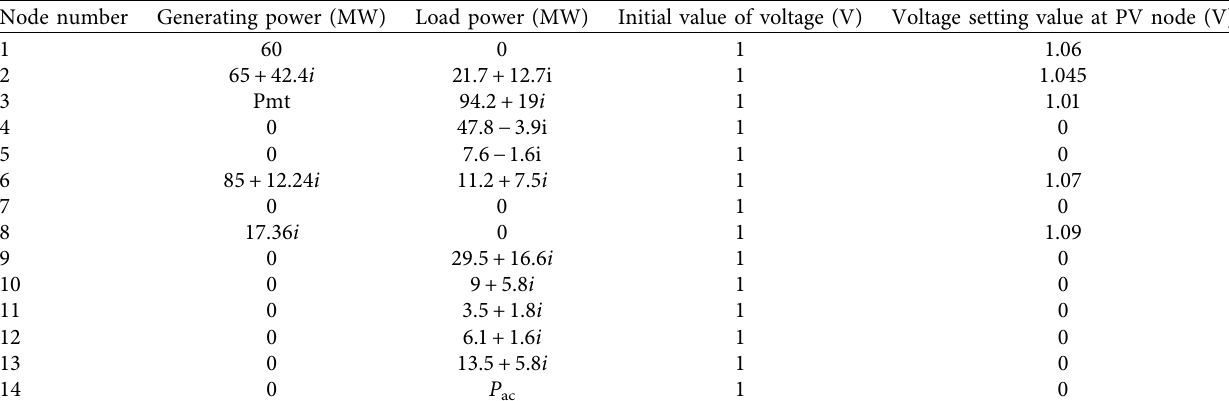
Figure 2: Schematic diagram of calculation example of the multi-energy system. Table 4: Power system node parameters.